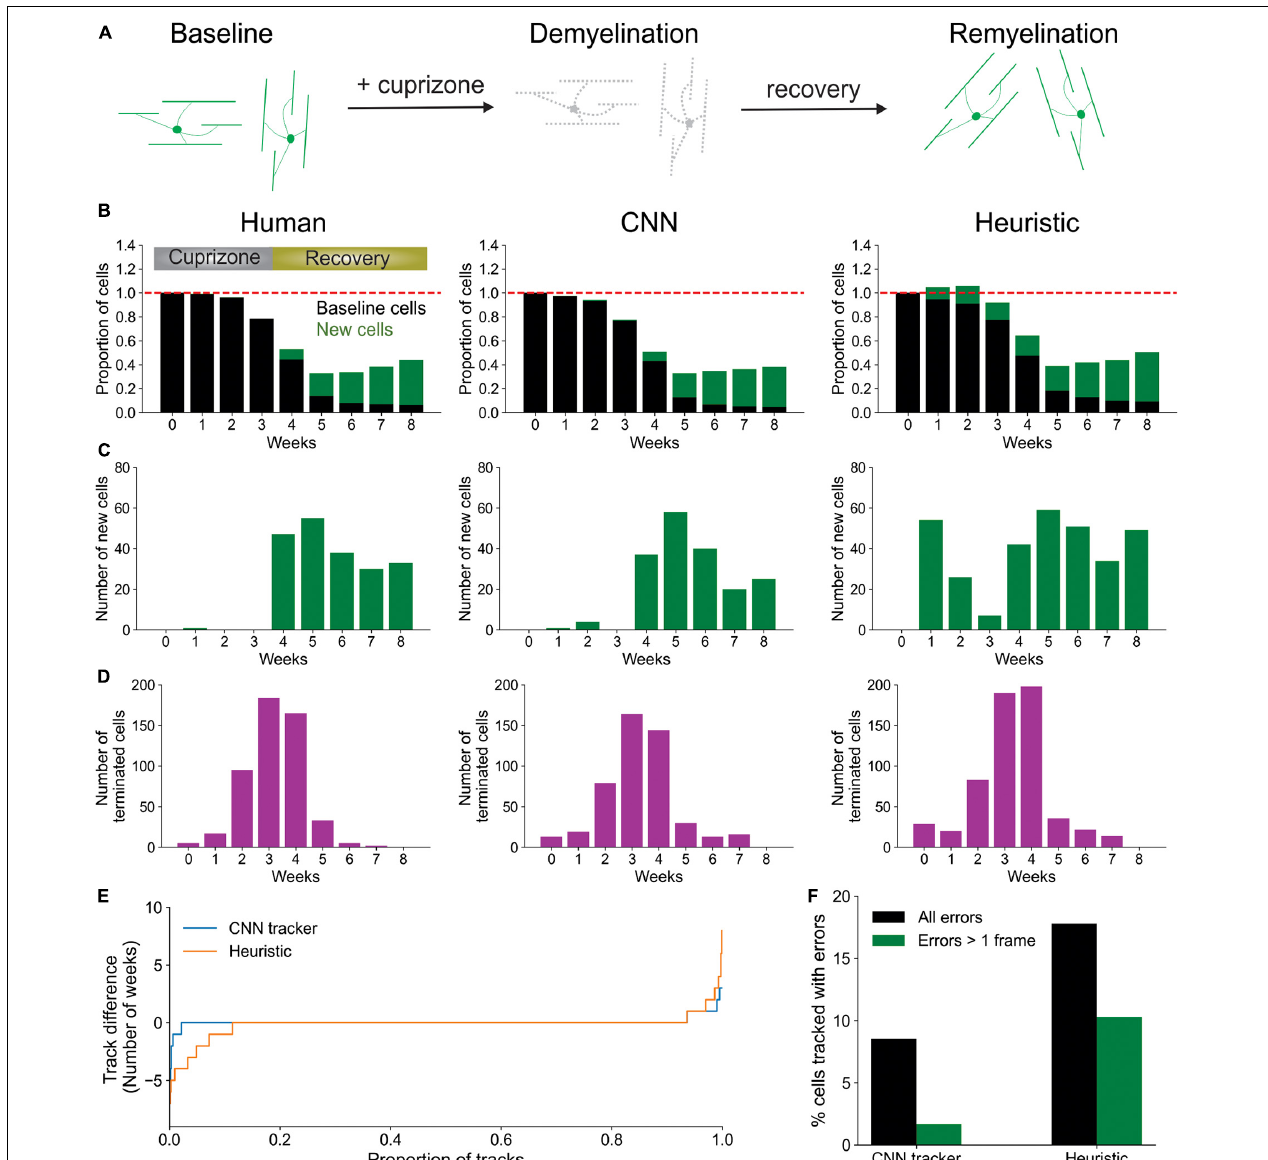
FIGURE 4 | CNN-based tracking outperforms heuristic tracking. (A) Diagram illustrating cuprizone induced oligodendrocyte loss and recovery during the imaging period. (B) Overall normalized trends for human, CNN and heuristic tracking methods on test timeseries withheld from training data. (C) Number of new cells detected per timepoint for each method. (D) Number of cells terminated per timepoint for each method. (E) Track difference (length of track in ground truth – length of track by machine count) comparing ground truth to CNN and heuristic methods, respectively. (F) Comparison of major errors, defined as under- or over-tracking for > 1 timepoint, and total errors by CNN and heuristic